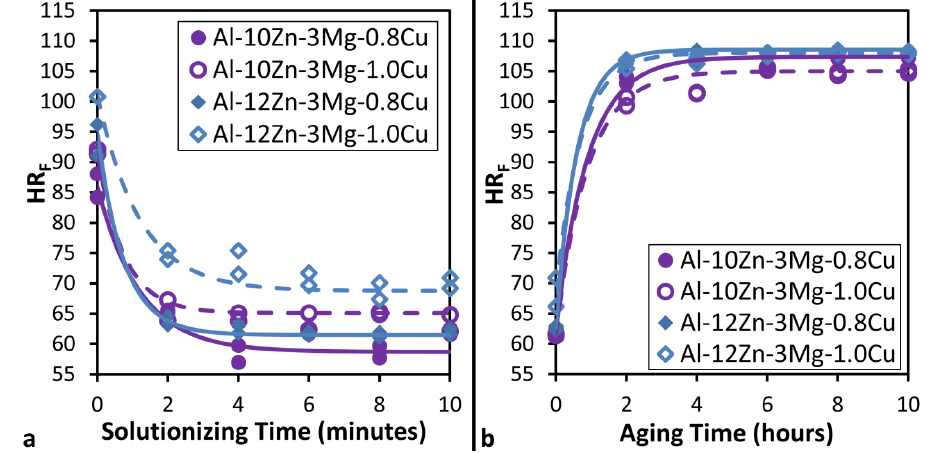
Figure 2. ( a ) Variation of Rockwell F Hardness ( HR (480 °C) followed by a water quench and ( b ) Variation of Rockwell F Hardness ( HR aging time at 393 K (120 °C) in Al-(10 to 12)Zn-3Mg-(0.8 to 1)Cu